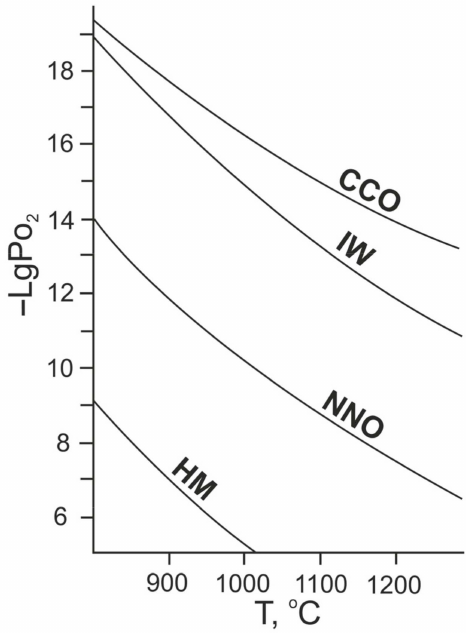
Figure 7. Equilibrium oxygen partial pressure for buffer reactions at 0.1 MPa (after